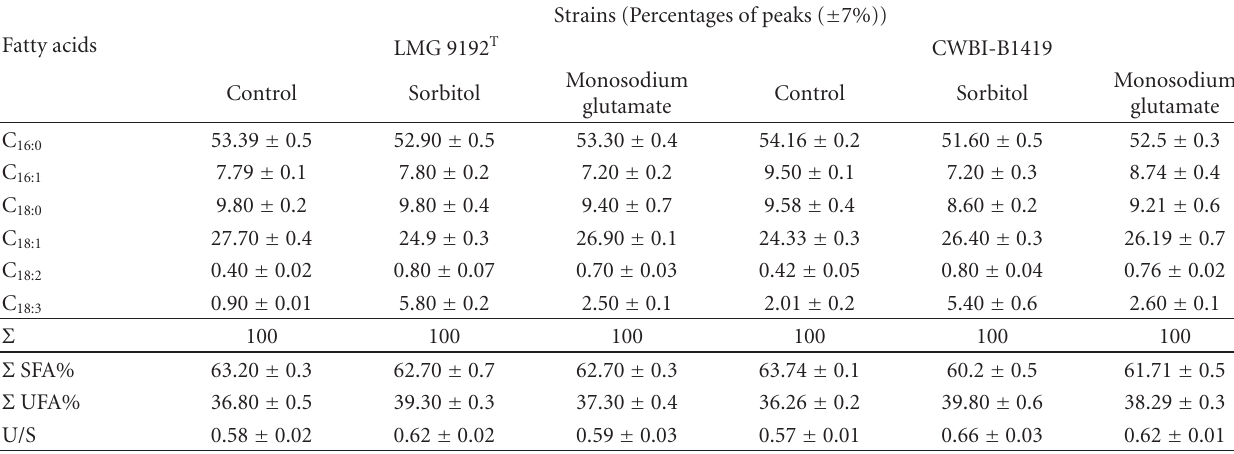
Table 1: Composition and modifications of membrane fatty acids (% of peaks areas) induced by growth temperature of L. paracasei ssp. LMG 9192 T and L. plantarum CWBI-B1419. The peaks were identified as hexadecanoic (palmitic) acid (C 16:0 ), hexadecenoic (palmitoleic) acid (C 16:1 ), octadecanoic (stearic) acid (C 18:0 ), cis-9-octadecenoic (oleic) acid (C 18:1 ), cis-7,12-octadecadienoic (linoleic) acid (C 18:2 )